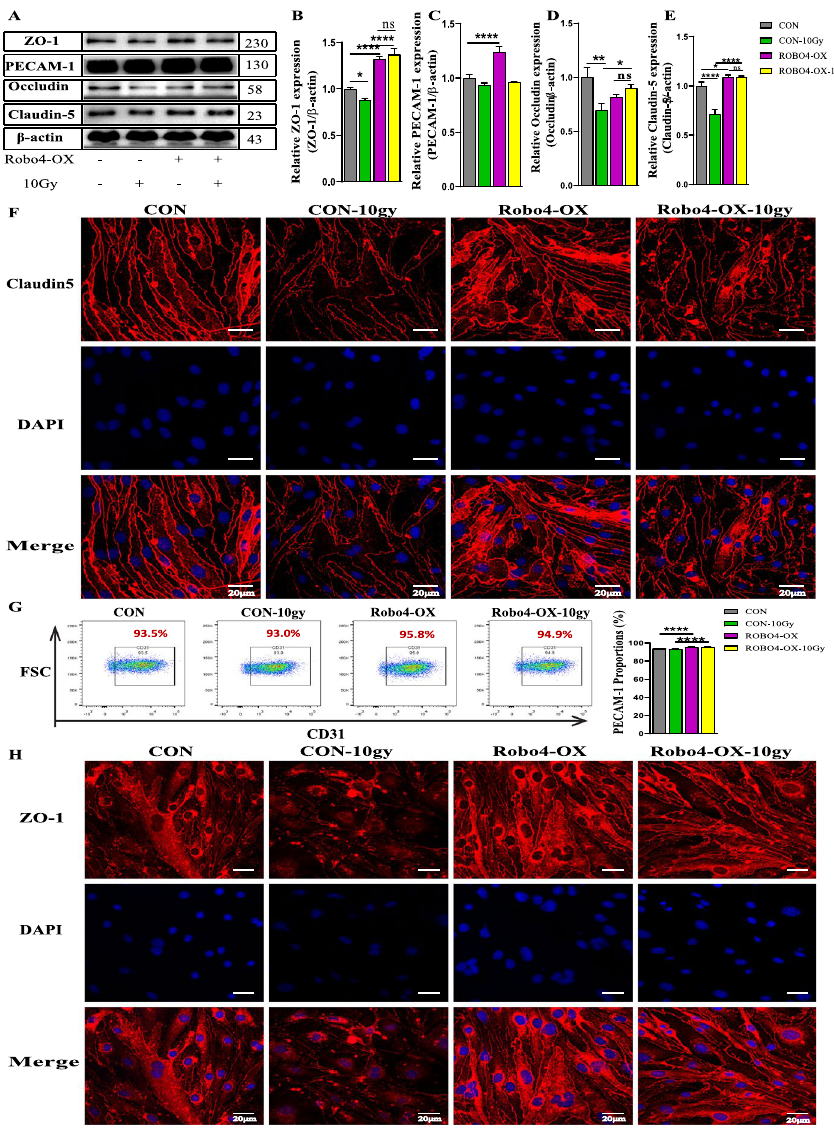
Fig. 5 Enhanced expression of Robo4 ameliorates the downregulation of TJs induced by IR. A – E Western blotting analysis showing the protein expression levels of claudin-5, occludin, PECAM-1, and ZO-1 in Robo4 overexpressed bEnd3 cells after irradiation. We used β-actin as a loading control. F and H Localization of claudin-5 and ZO-1 in microvascular EC samples by confocal microscopy following IR, respectively. The nuclear stain is DAPI. G Assessment of CD31 expression in the microvascular ECs 24 h